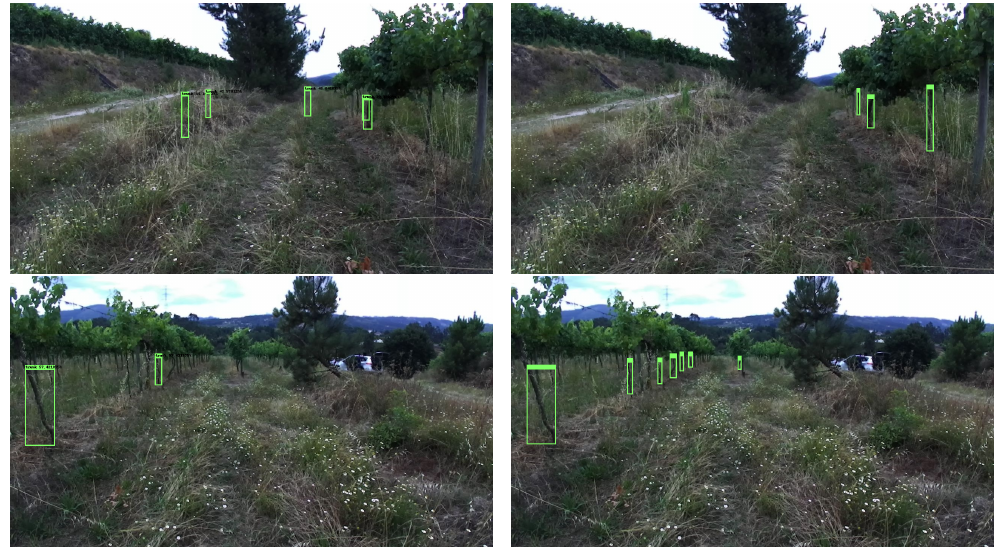
Figure 16. The result of the model in the complex